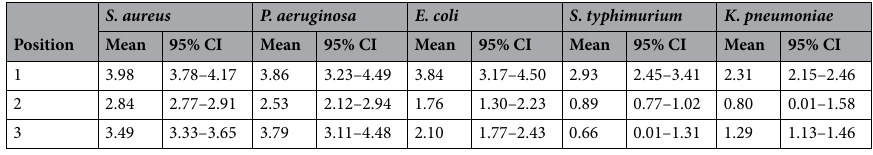
Table 1. Microbes log 10 reduction after 15 h exposure to VBL405.